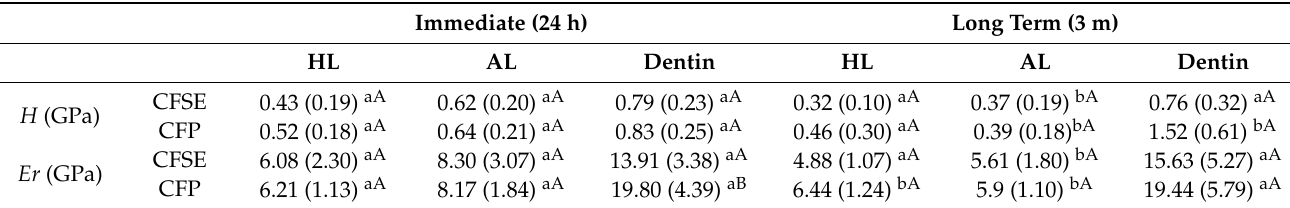
Table 5. Hardness ( H ) and reduced Young’s modulus ( Er ) means (in GPa), and standard deviations shown between parenthesis, according to the adhesive (CFSE, CFP) and time point (24 h and 3 months). Different capital letters identify statistically significant differences within the same column, while different small letters identify significant differences within the same row (Dunn–Bonferroni, p < 0.05; n = 3).